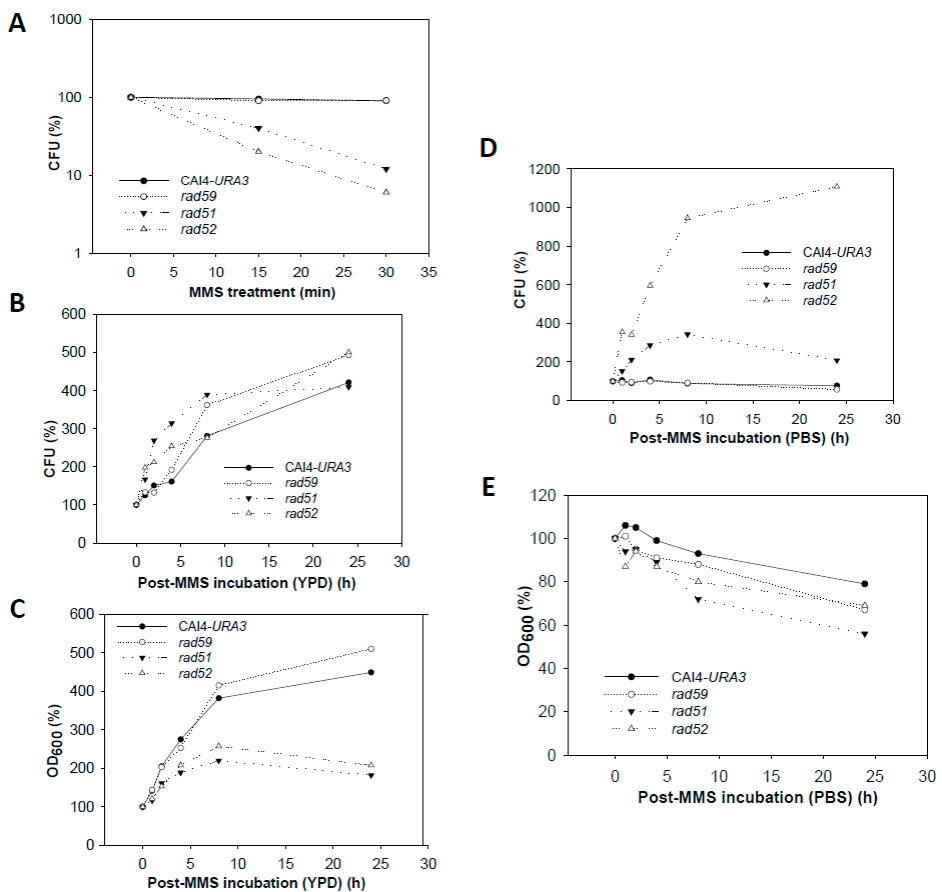
Figure 7. Changes in CFU and OD 600 from wild type and HR mutants during MMS treatment and recovery. ( A ) Cell survival after the acute MMS-treatment. Survivability in terms of CFU was 95% for wild type (CAI4-URA3) and Ca rad59 - ΔΔ , 12% for Ca rad51 - ΔΔ , and 5% for Ca rad52 - ΔΔ . ( B , C ) Variation of CFUs and OD 600, respectively, during recovery of MMS-treated cells in YPD. ( D , E ) Variation in CFU and OD 600 , respectively during recovery in PBS.